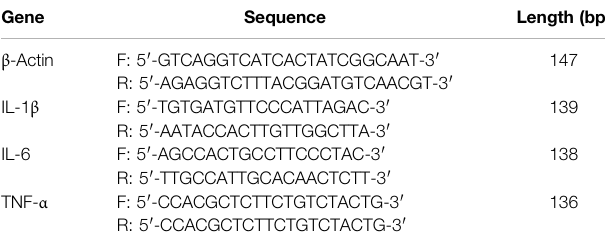
TABLE 1 | Primers utilized in